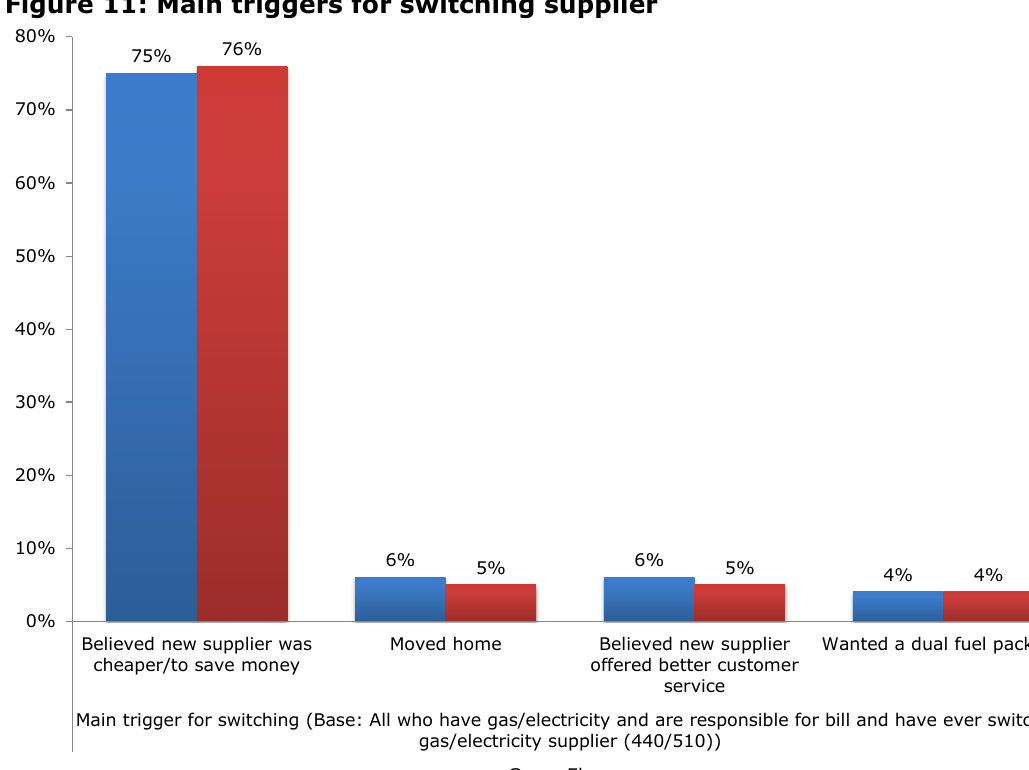
Figure 11: Main triggers for switching